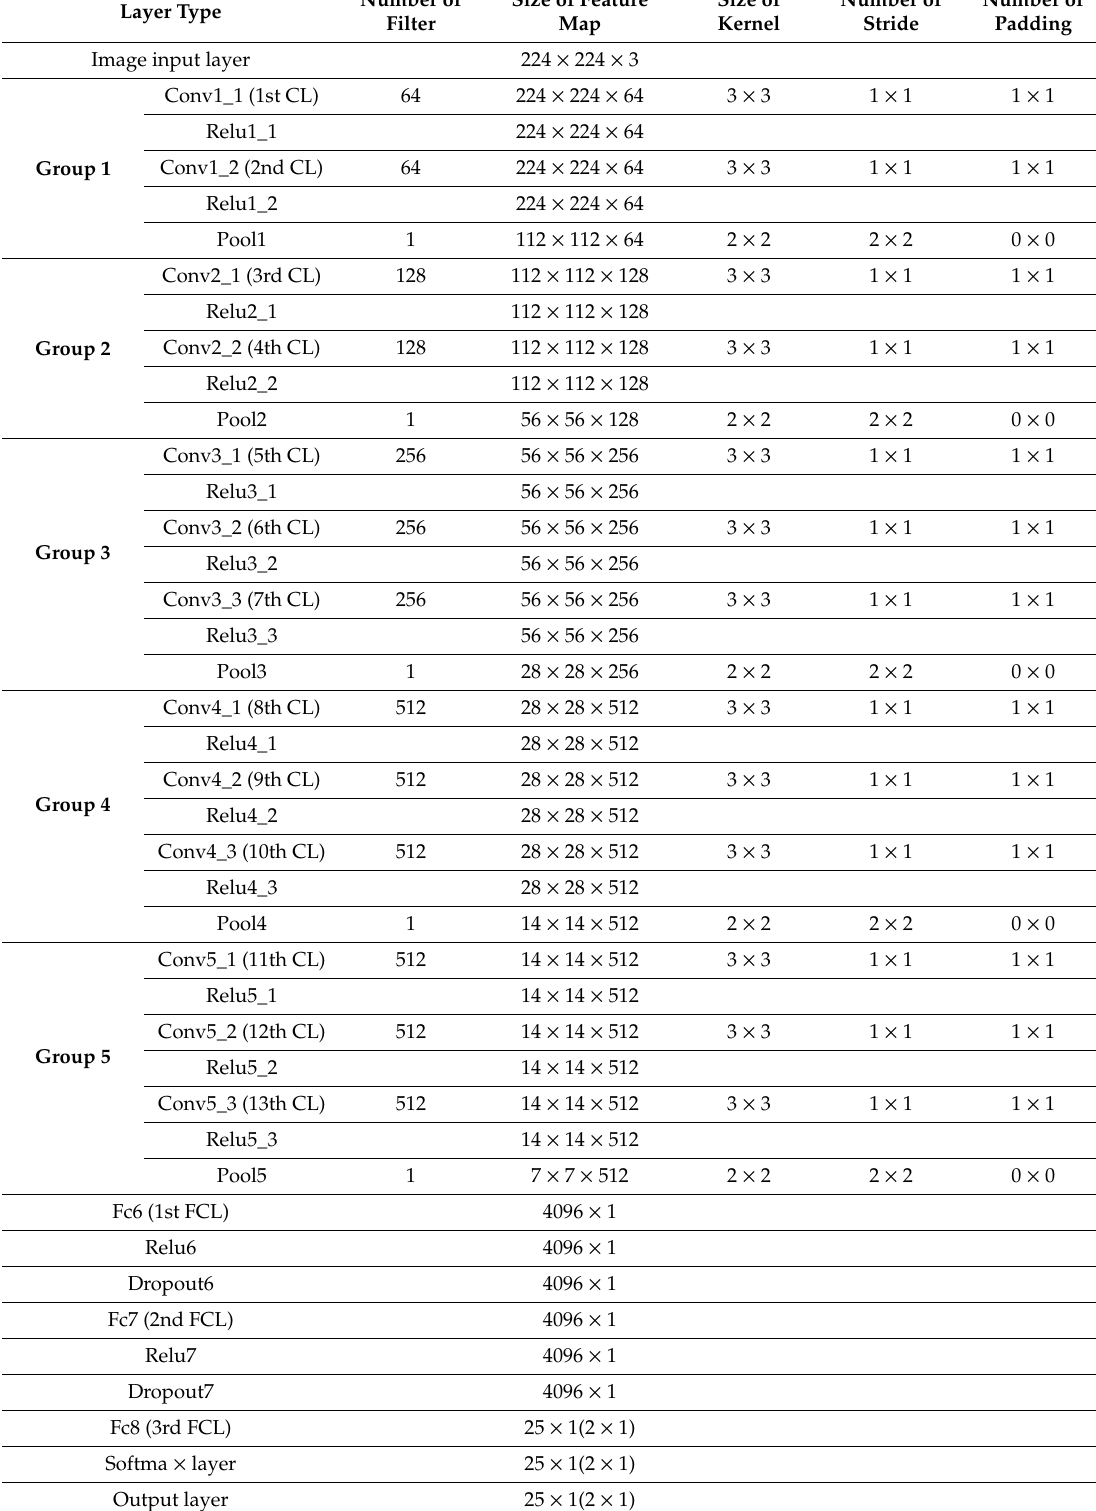
Table 2. Configuration of CNN model used in proposed method (CL means convolutional